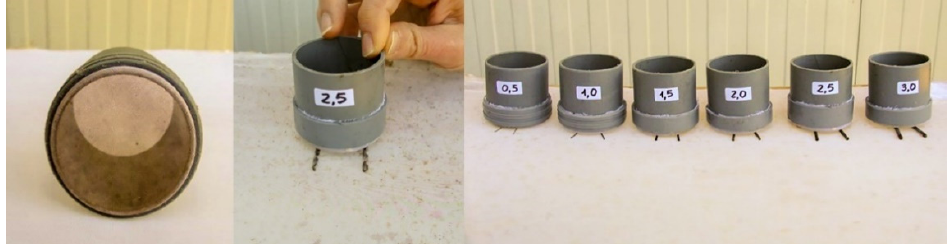
Figure 2. The plastic cylinders with a base made of tulle tissue used as containers for medfly larvae to be parasitised and the metal bars used to set the different distances in laboratory tests.